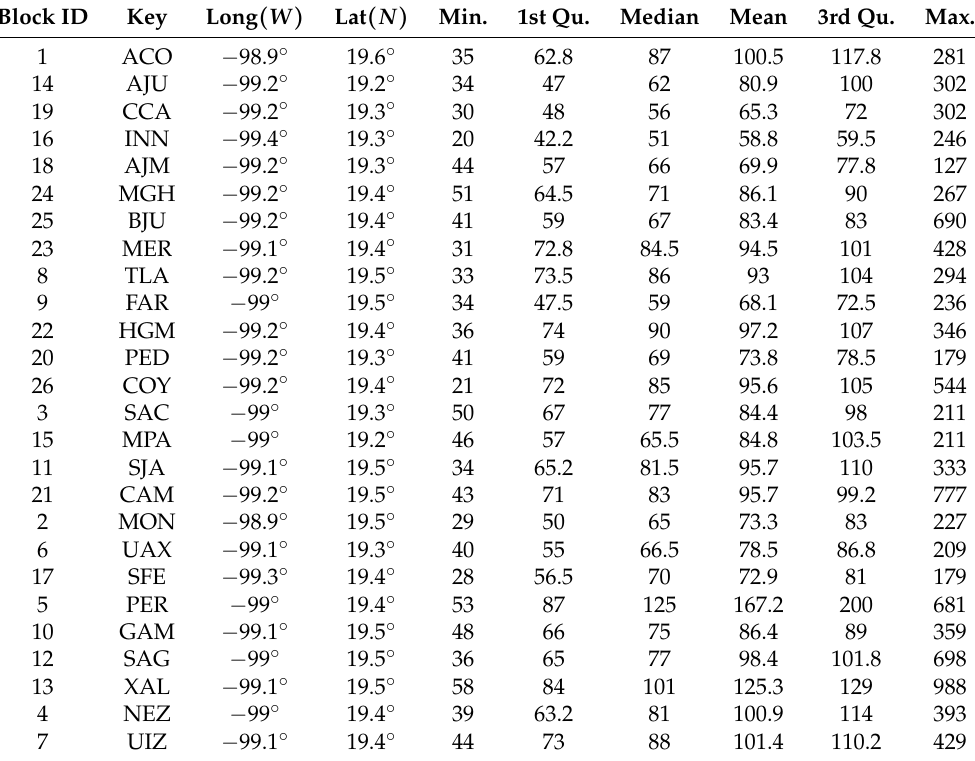
Table 1. Descriptive summary information on the PM2.5 maxima in the Mexico City metropoli- tan